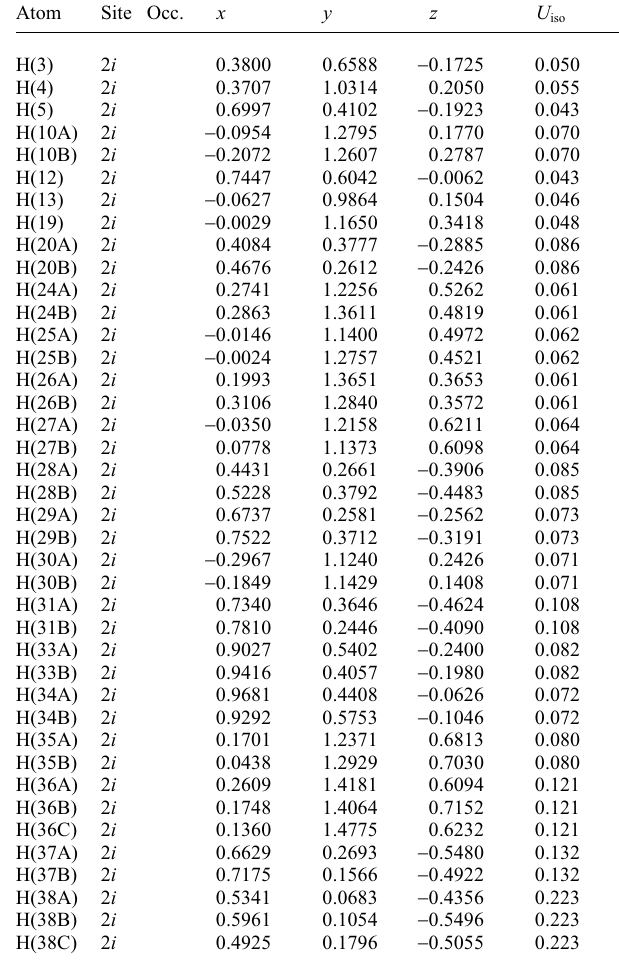
Table 2. Atomic coordinates and displacement parameters (in Å 2 )